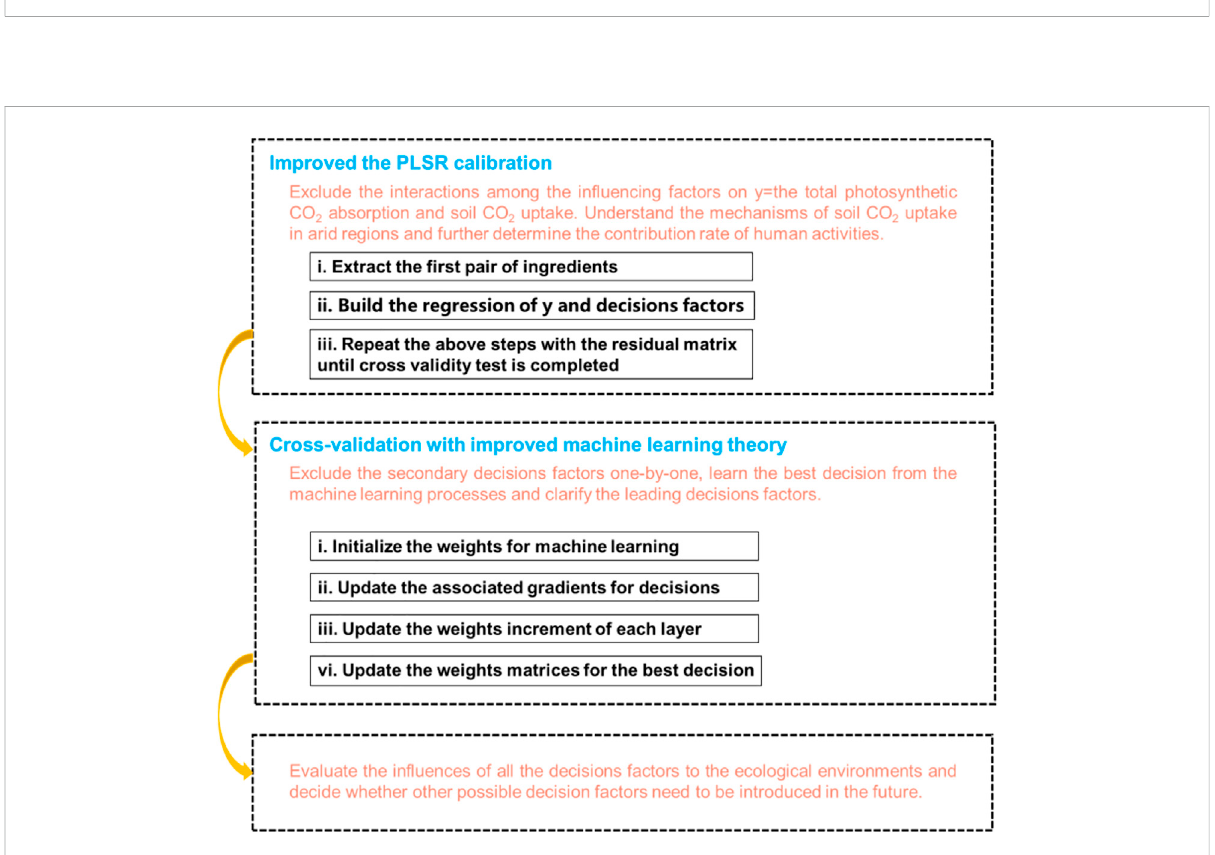
FIGURE 8 Perspective scheme to comprehensively consider the total reinforcement of photosynthetic CO 2 absorption and soil CO 2